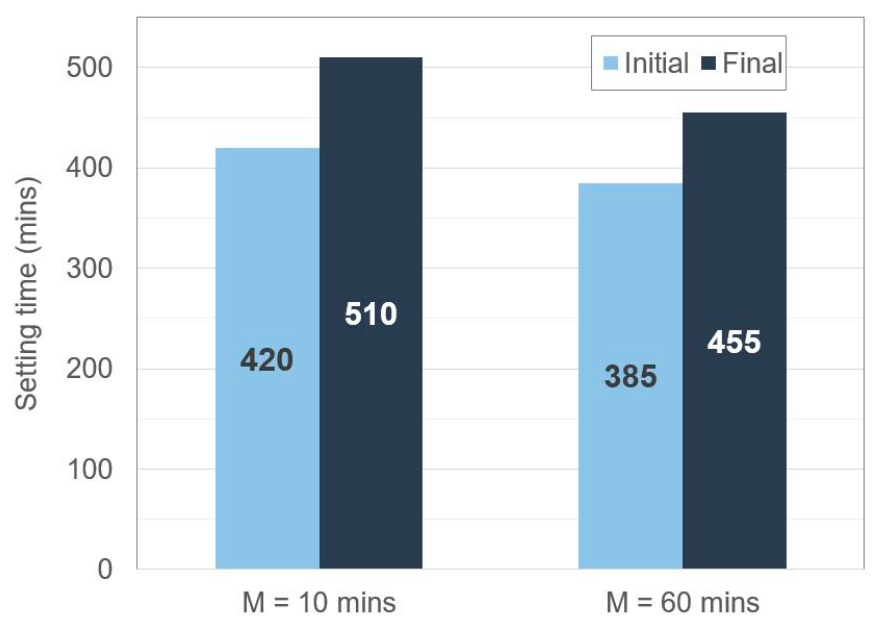
Figure 12. Vicat Needle initial and final setting times of geopolymer samples mixed for M = 10 min and M = 60 min.